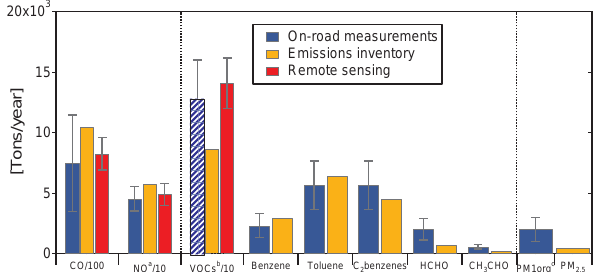
Fig. 3. Comparison of LDGV on-road mobile emissions estimated from this work, from remote sensing (Schifter et al., 2008) and the 2006 – criteria and toxic – emissions inventories (SMA, 2008a, b). The uncertainty bars displayed are standard errors of the means. For clarity, emissions of CO, NO, and VOCs are divided by factors of 100, 10 and 10, respectively. a NO x emissions in the inventory were assumed 90% NO and 10% NO 2 in mass. b Total VOCs emissions from the inventory include evaporative emissions. The correspond- ing on-road VOC’s are inferred rather than measured (see text for details). c Estimated organic mass of particles in the non-refractive PM 1